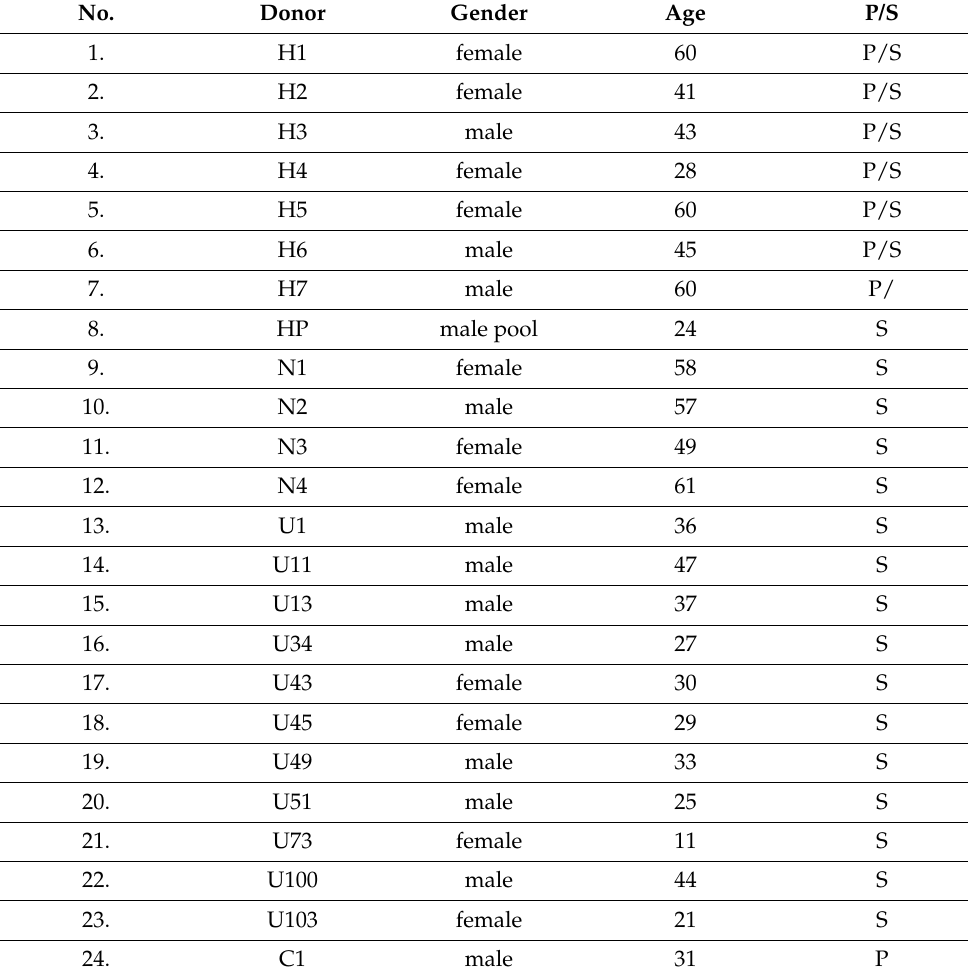
Table 1. Demographic data of blood